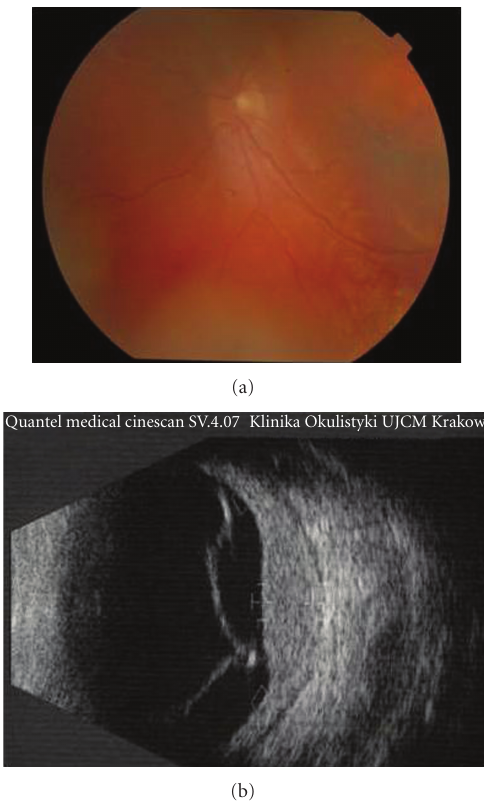
Figure 2: Fundus and B-scan ultrasonography demonstrating di ff use choroidal hemangioma with extensive exudative retinal detachment.